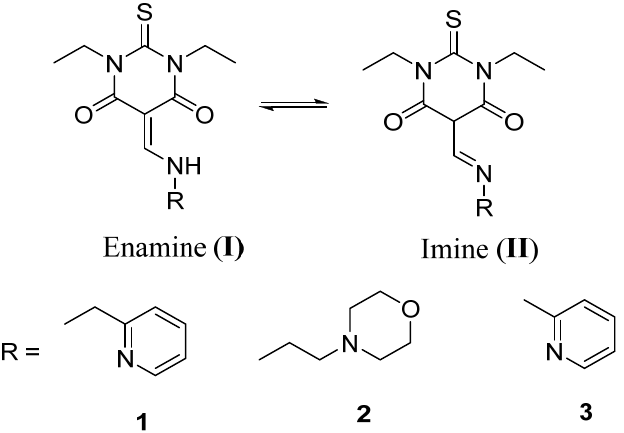
Figure 11. Enamine / imine tautomeric forms of compounds 1 – 3 . Figure 11. Enamine/imine tautomeric forms of compounds 1 − 3 . Table 6. Calculated reaction profile using the 6 − 311G ++ (d,p) basis set.